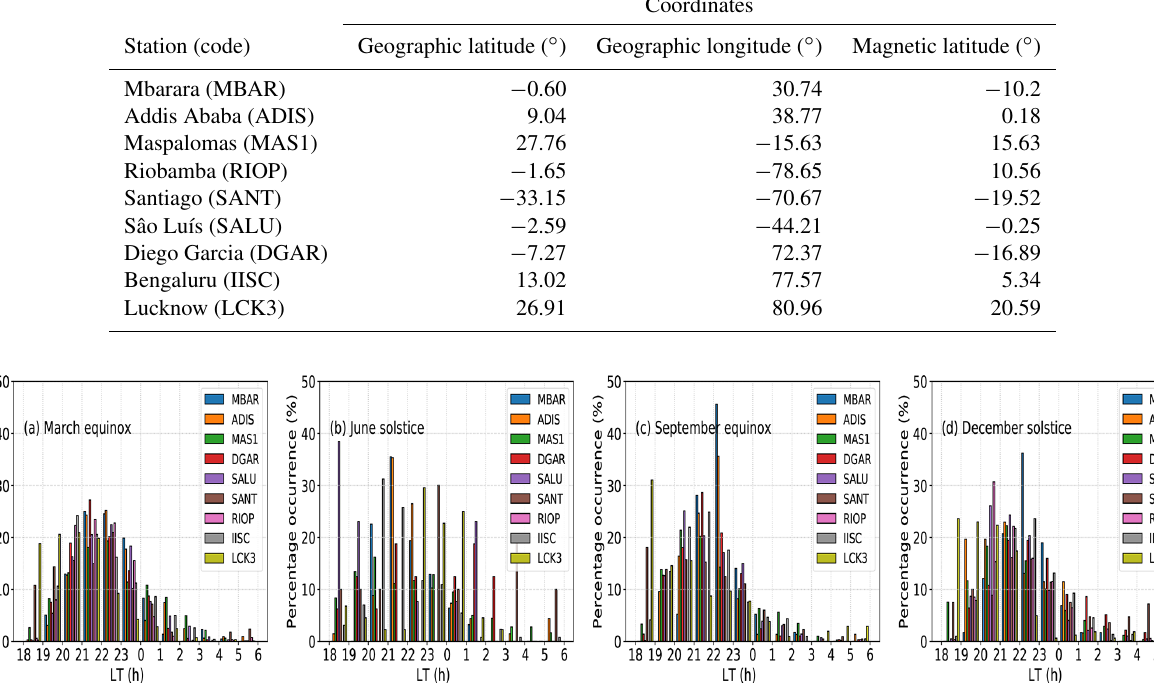
Figure 5. Percentage occurrence of ROTI of > 0 . 5TECUmin − 1 in 1h LT bins for different stations (see legend).